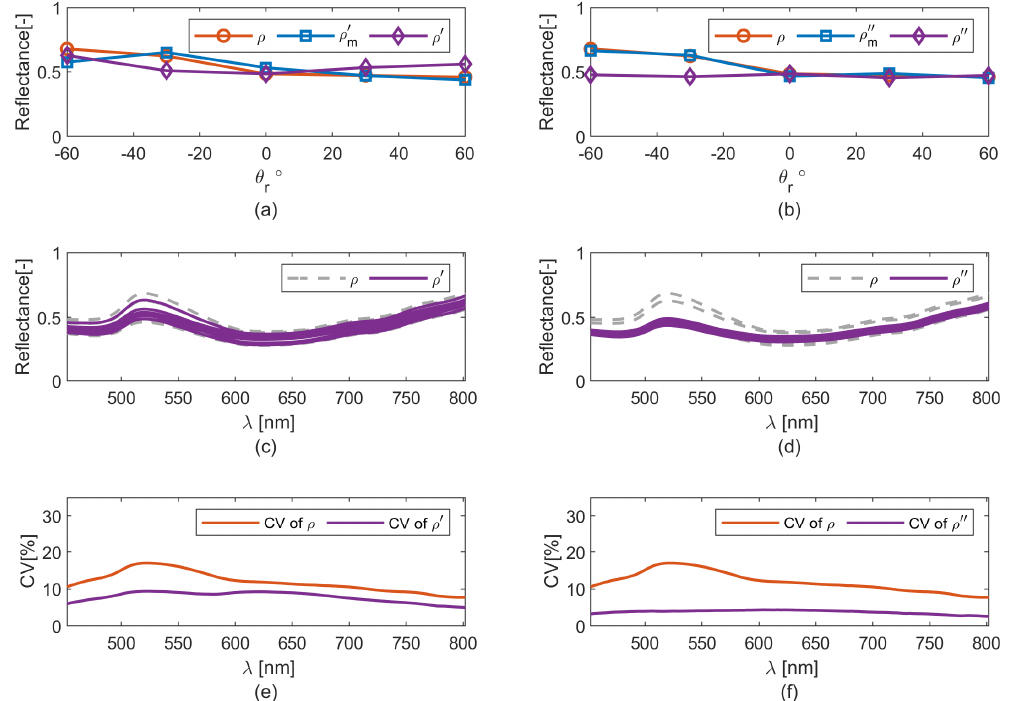
Figure 2. Evaluation of the BRDF correction models for the microstructure pattern A. Left and right columns, correction without considering and considering the spectral mixture, respectively. The second row presents the measured pixels' reflectance signatures before the BRDF correction (gray dashed lines) and after the correction (solid magenta lines). The third row shows the CV for each band before and after the